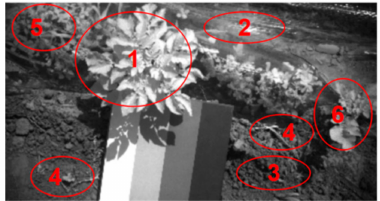
Figure 3. Image of a potato plant at 888 nm in the field. 1 : target plant, 2 : mulch film, 3 : soil, 4 : residual straw; 5 : weeds, 6 : non-target potato